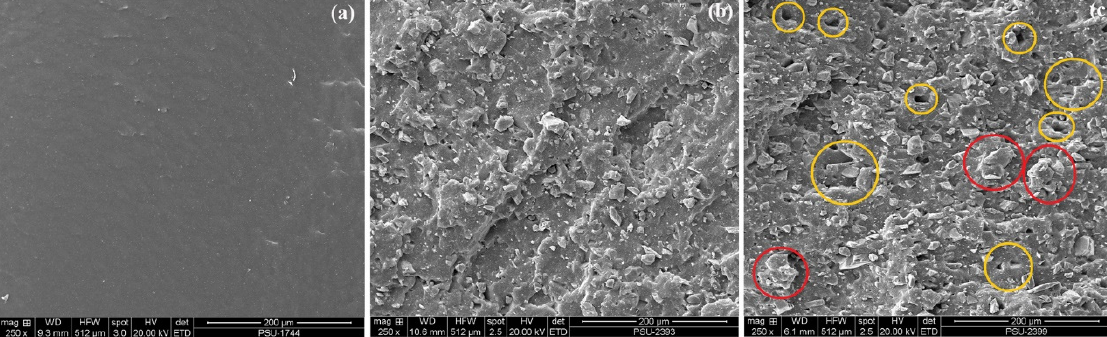
Figure 4. SEM images of fracture surfaces on TiO 2 -filled NBR composites with ( a ) 0 phr TiO 2 (or pure NBR), ( b ) 70 phr TiO 2 , and ( c ) 110 phr TiO 2 .